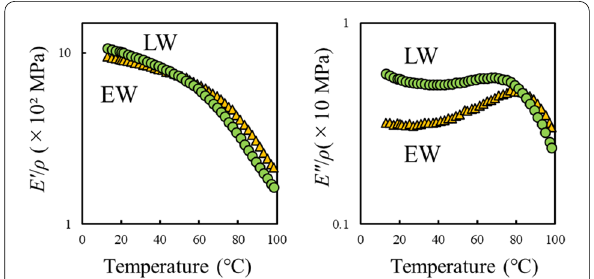
Fig. 4 Temperature dependence of E’ / ρ and E’’ / ρ in tangential direction of Douglas fir swollen by water at 0.5 Hz, where ρ is the specific gravity of the sample. Green filled circles, latewood (LW); orange filled triangle, earlywood